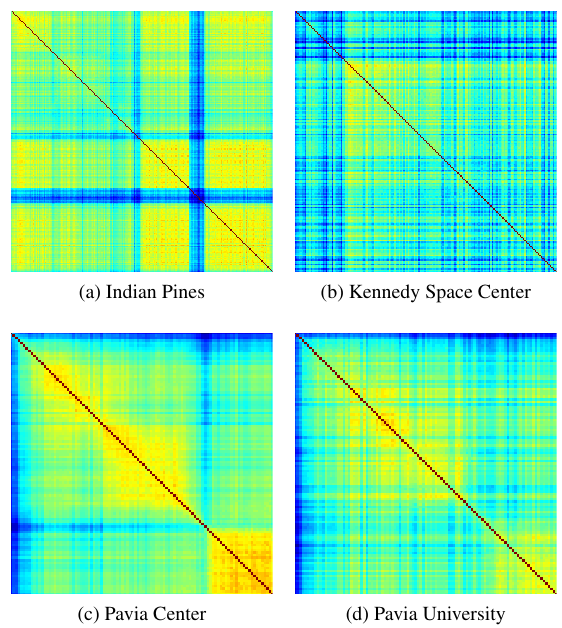
Figure 6: Correlation of bands based on classification maps